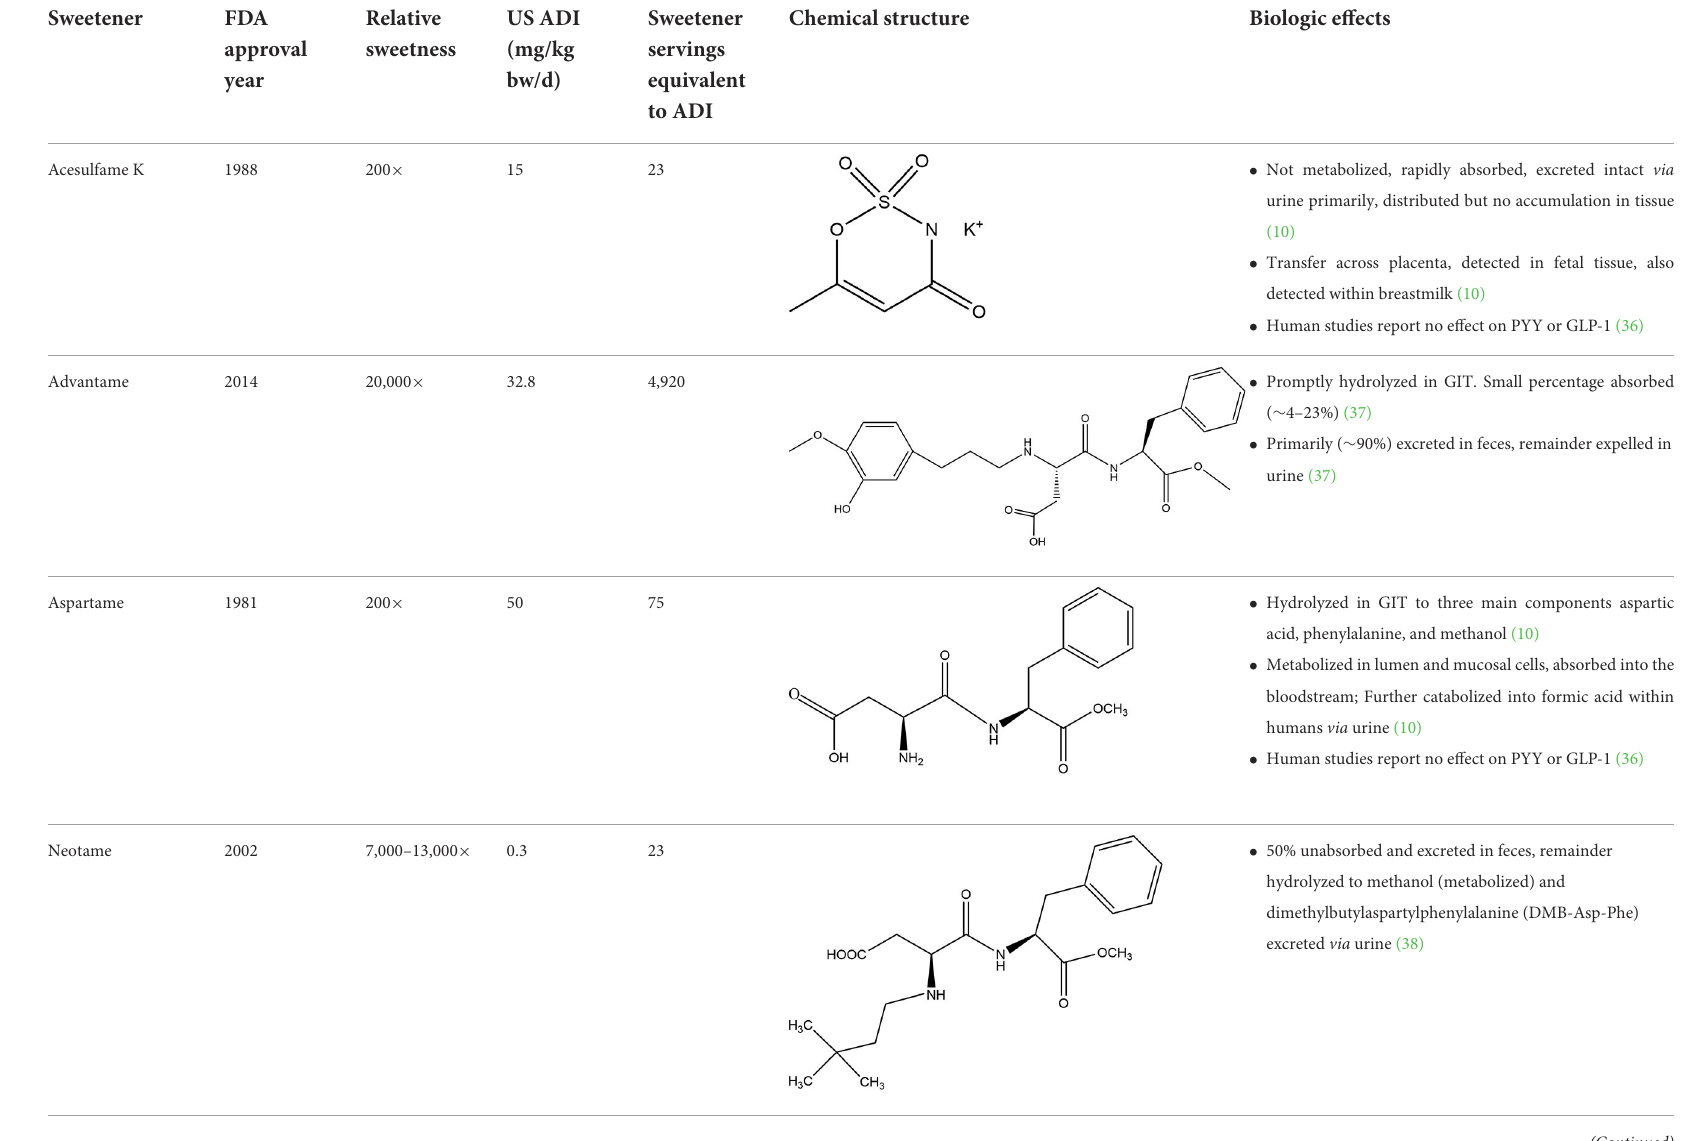
TABLE 1 Characteristics of non-nutritive sweeteners approved for